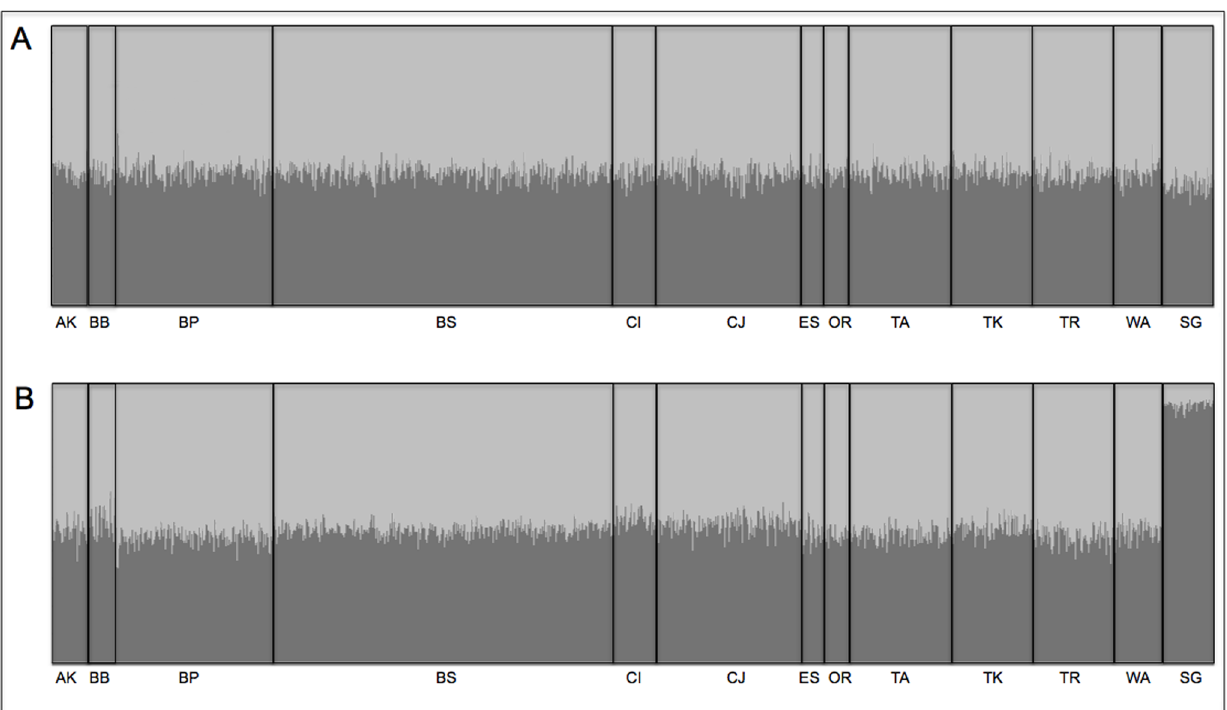
Figure 2. STRUCTURE analysis. STRUCTURE outputs for the admixture model without a location prior ( a ) and the admixture model with the location prior ( b ). The genome of each individual fish is represented by a thin vertical line as assayed by nine microsatellite markers, where each shade of grey represents a unique genetic cluster, and the proportion of each genetic cluster that contributes to an individual’s genome is illustrated by the relative amount of each shade within each vertical line. Under the admixture model without a location prior, all individuals exhibit roughly equal admixture between the two genetic clusters (q is approximately 0.5). Under the admixture model with a location prior, however, the Strait of Georgia individuals exhibit a q-value close to 1.0, while the outer coast location individuals still exhibit equal admixture of both clusters.